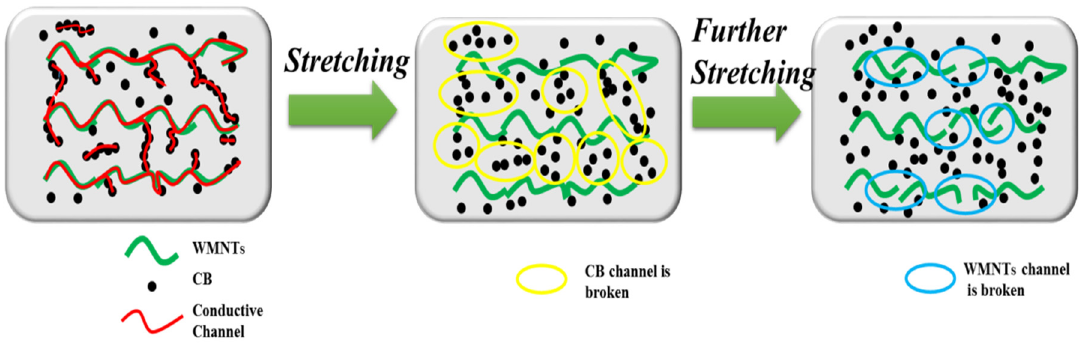
Figure 5. Schematic diagram of the conductive network path of the flexible strain sensor and evolution of the conductive network path under stretching.